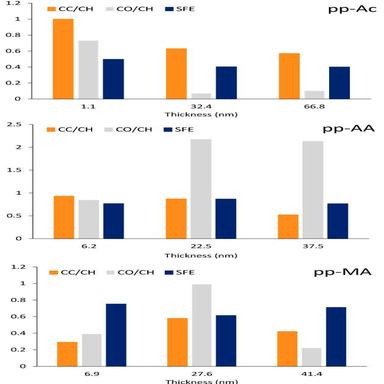
Relationship between the overall thickness and the chemical structure of the three plasma polymers determined by FTIR ratio (CC/CH, CO/CH), surface free energy (SFE) (10+2 mJ m− 2 ).